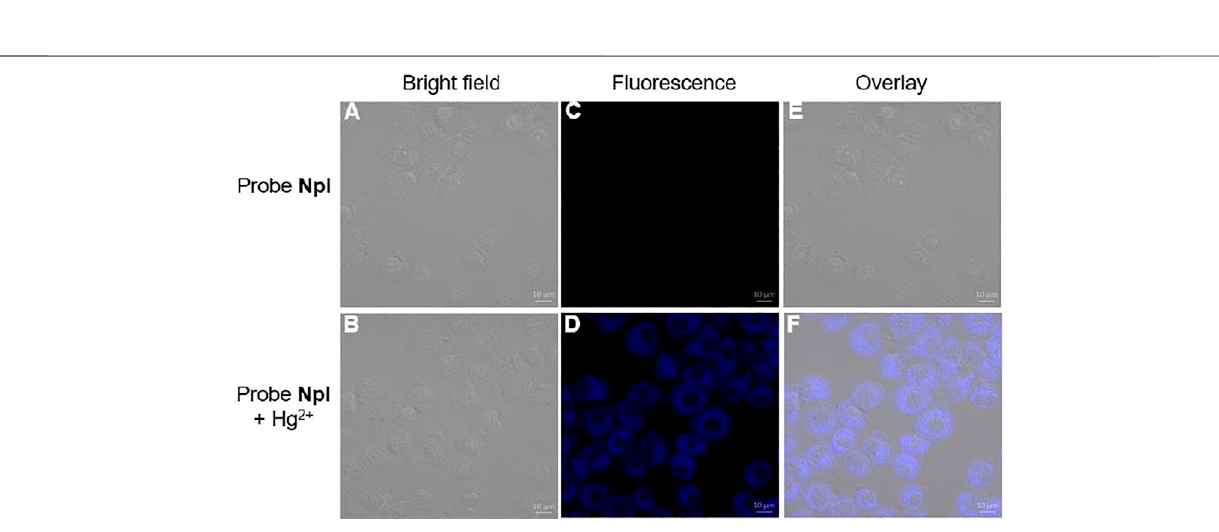
Frontiers in Chemistry |